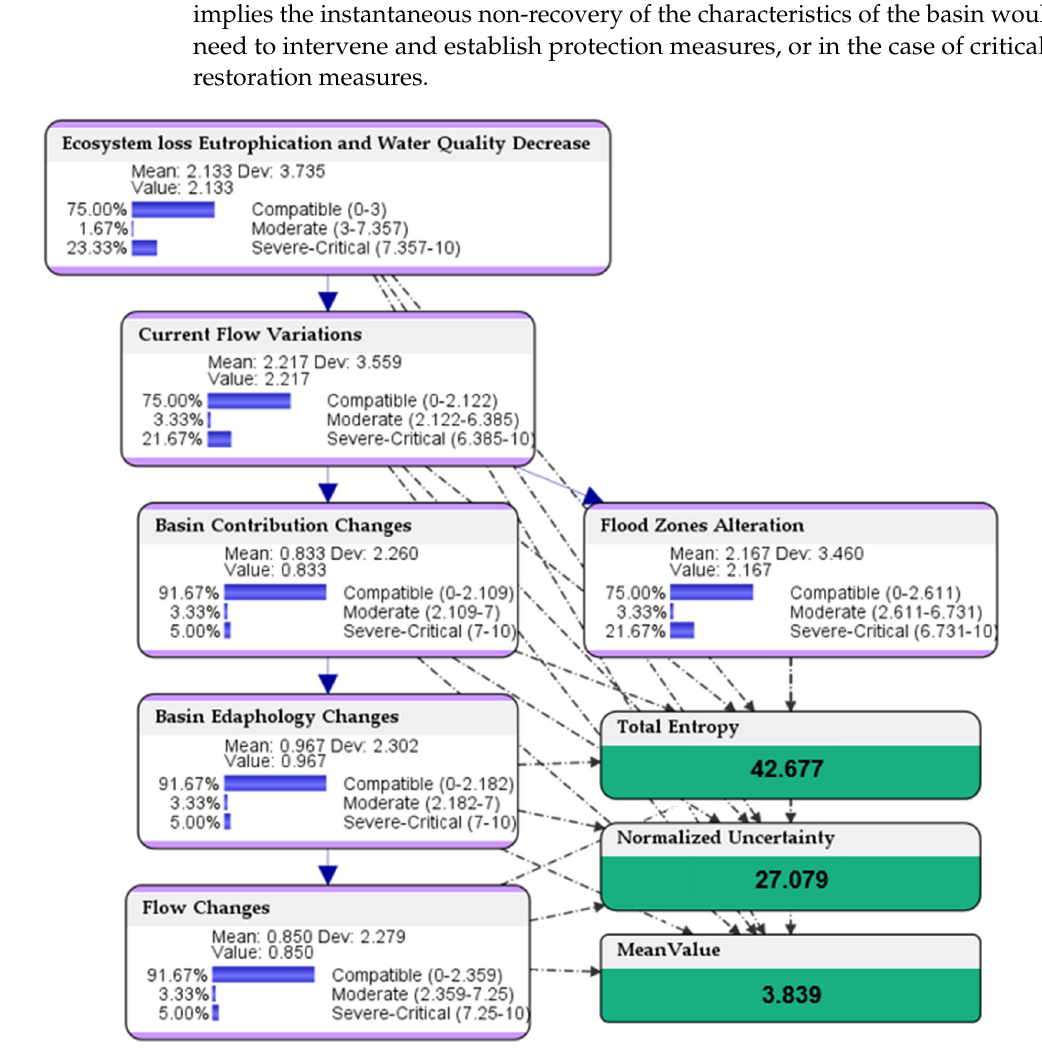
Figure 5. A priori probabilities for the variables before conducting inference analysis.